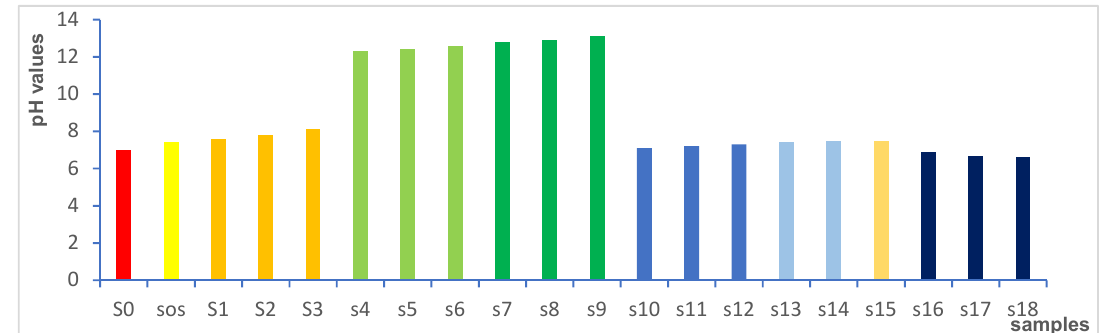
Figure 22. Effect of chemical and granular stabilization on soil sample pH values.